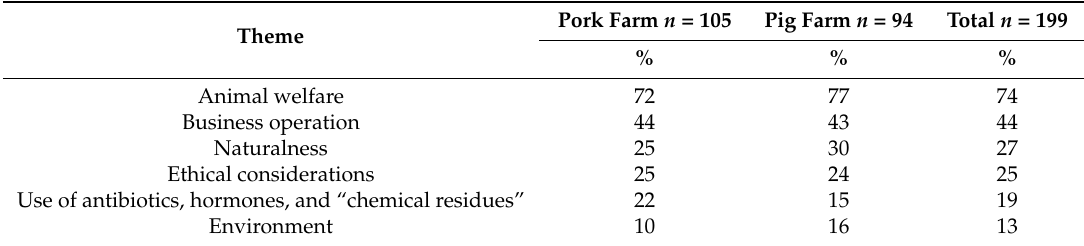
Table 1. Emergent themes in response to the question, “What do you consider to be an ideal pig/pork farm and why are these characteristics important to